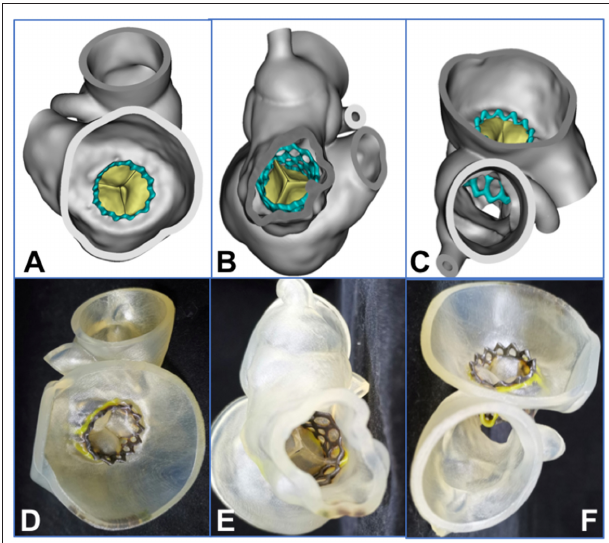
FIGURE 5 | Assessment of 3-dimensional (3D) reconstruction is completed by using post-procedural computed tomographic data (e.g., data for patient 2). (A–C) 3D reconstruction from the plane of the left atrium, the left ventricle, and the ascending aorta, respectively. (D–F) The 3D printed model from the plane of the left atrium, the left ventricle, and the ascending aorta, respectively. The yellow area represents the frame of the degenerated valve, and the black area is the frame of the balloon-expandable